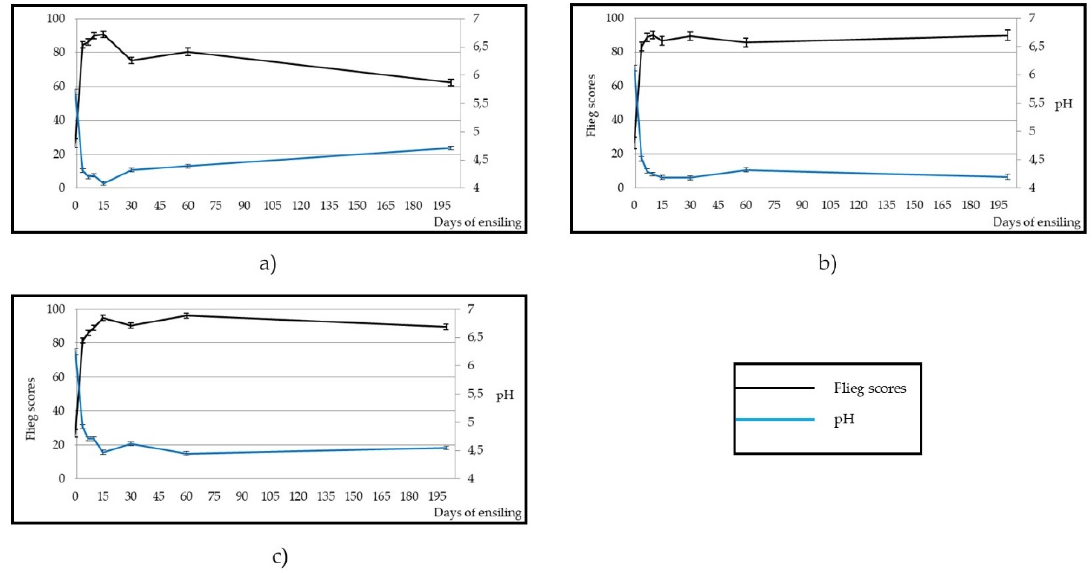
Figure 3. Effect of ensiling on Flieg scores and pH in broccoli by-product ( a ), artichoke by-product ( b ) and artichoke plant stubble ( c ) silages.